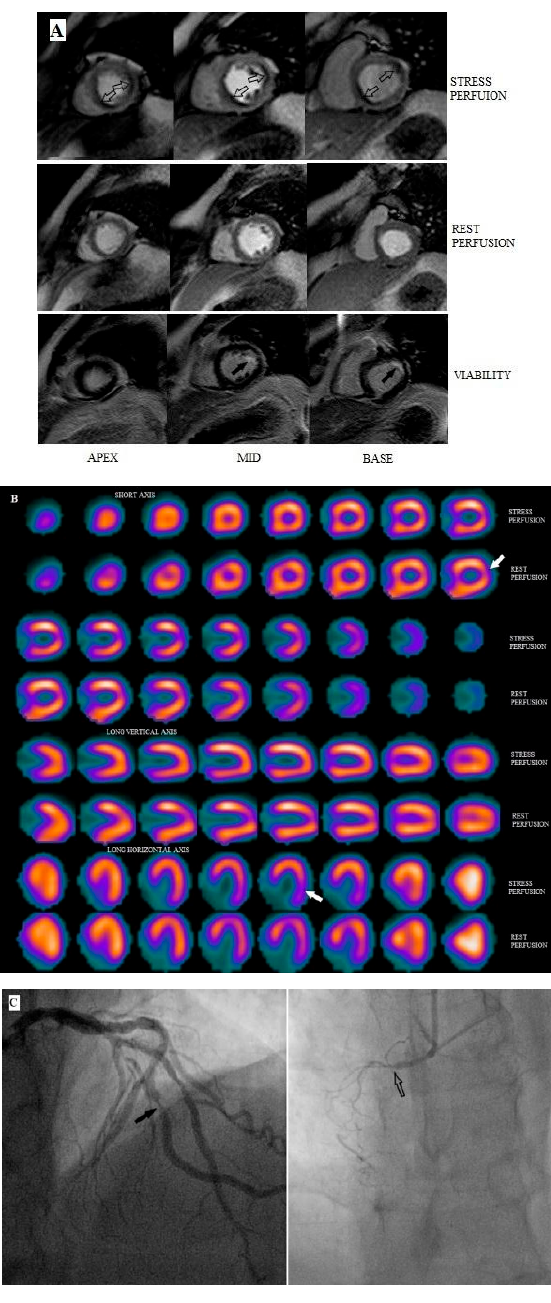
Figure 1. Representative images from a 72 year-old male patient with chest pain. ( A ) Stress-rest cardiac magnetic resonance (CMR) images show stress-induced perfusion defects (ischemia) in the lateral-anterolateral and inferoseptal left ventricular walls of the basal, mid and apical slices (open arrows) and subendocardial late gandolinium enhancement (LGE) (non-transmural infarction) in the anterolateral wall at the basal and mid-ventricular slices (black arrows). ( B ) single-photon emission computed tomography (SPECT) shows a partially reversible defect (white arrows) at the lateral and anterolateral left ventricular walls, but fails to demonstrate the inferoseptal ischemia. ( C ) SCA demonstrates a significant ( > 70%) luminal stenosis (left panel, black arrow) at the obtuse marginal branch and occlusion of the right coronary artery (right panel, open arrow) confirming the CMR